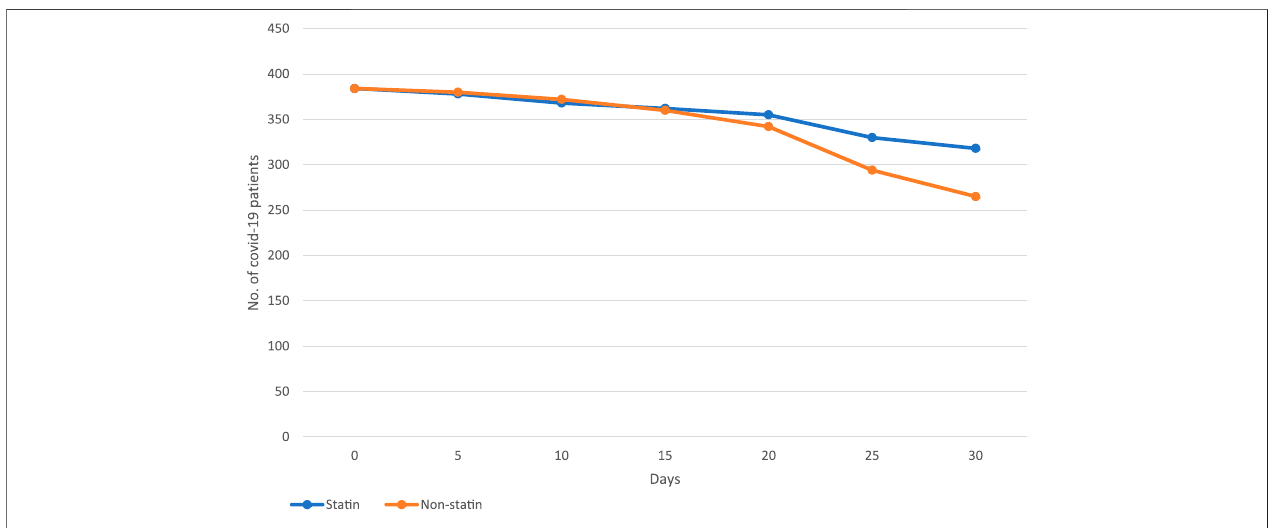
FIGURE 2 | Survival curves depicting statin and non-statin use after Propensity score